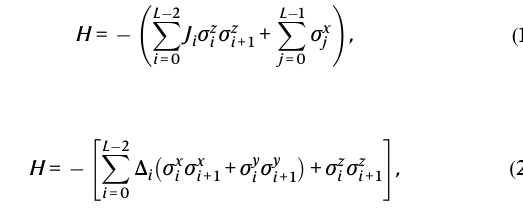
measurementsofinterest.Inquantumtomography( b ),therawmeasurementdata arefed intoastatisticalestimator(suchasmaximumlikelihood),whichproducesa guess for the density matrix ρ . Then, the density matrix is used to predict the outcome probabilities of unperformed quantum measurements via the Born rule. Both GQNQ and quantum tomography use data to infer a representation of the quantum